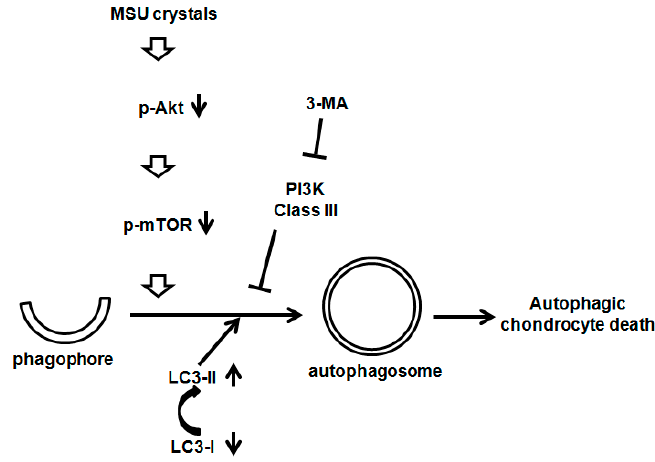
Figure 6. The effect of MSU crystals on the Akt/mTOR/autophagy signaling pathways.